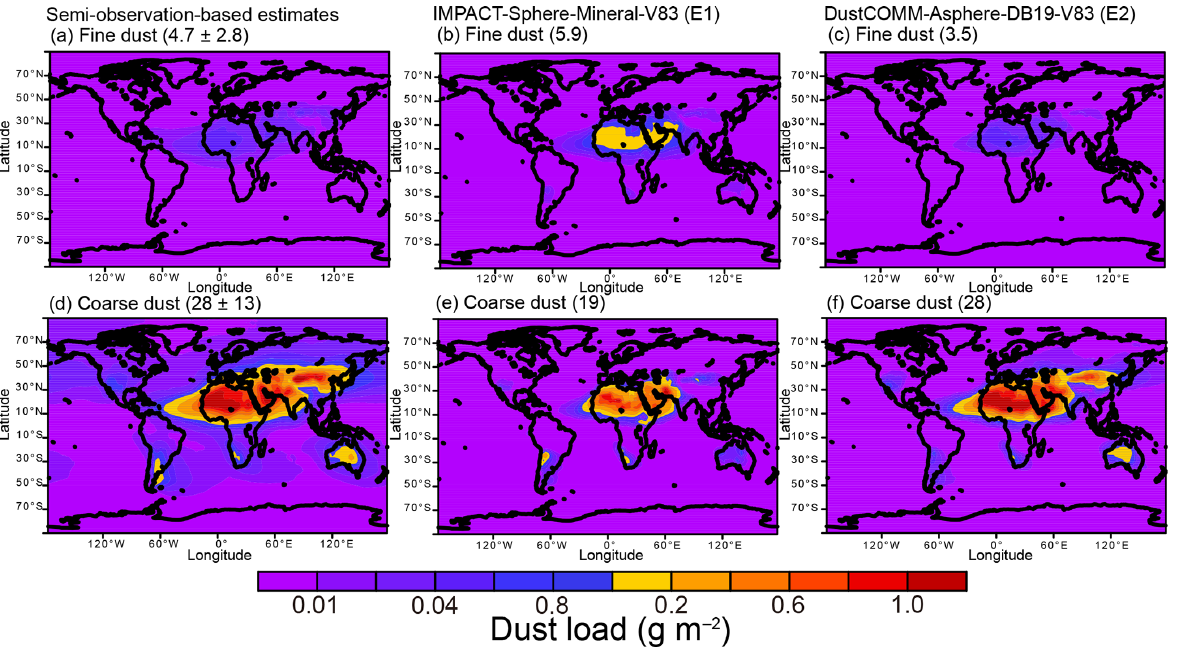
Figure 3. Model-simulated dust loads at fine (smaller than 2.5µm in diameter) and coarse size ranges (larger than 2.5µm in diameter) before and after adjusting the size-resolved dust load with DustCOMM. Results are shown for (a) fine dust from DustCOMM, (b) fine dust from IMPACT-Sphere-Mineral-V83 (E1), (c) fine dust from DustCOMM-Asphere-DB19-V83 (E2), (d) coarse dust from DustCOMM, (e) coarse dust from E1, and (f) coarse dust from E2 simulations. The parentheses represent the global dust burden (Tg). The values of dust load at each bin are listed in Table 3.